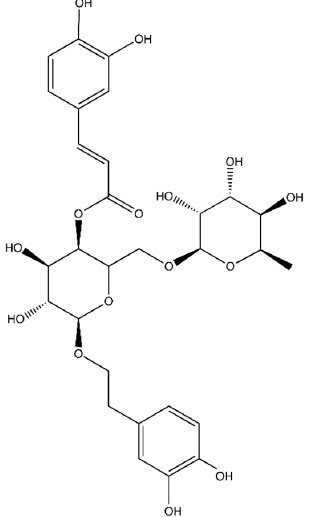
Figure 1. Chemical structure of forsythoside A.